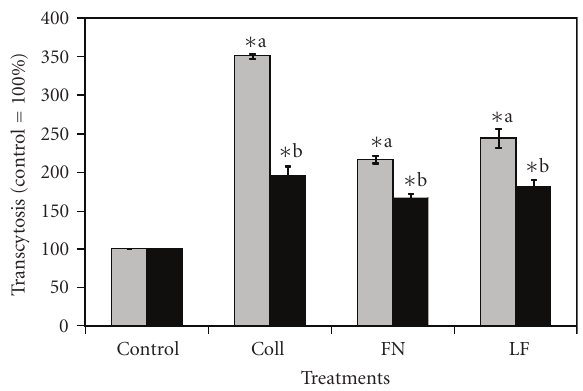
0200400600800100012001400 Figure 4: Transcytosis of Streptococcus uberis pretreated with host proteins across bovine mammary epithelial cells treated with the receptor mediated endocytosis inhibitor monodansylcadaverine detected at di ff erent incubation times. Fibronectin (FN), collagen (Coll), or bovine lactoferrin (LF) pre-treated S. uberis UT888 was cocultured with bovine mammary epithelial cells treated with the receptor-mediated endocytosis inhibitor monodansylcadaverine (MDC), and colony forming units per ml (cfu/mL) of S. uberis that transcytose bovine mammary epithelial cells were calculated at 60 ( ), 120 ( ), and 180 ( ) min of incubation. Data are presented as the percentage of transcytosis through monodansylcadaverine treated bovine mammary epithelial cells (100%, 60 minutes = 5.1 × 10 2 , 120 minutes = 6.3 × 10 2 ; 180 minutes = 1.0 × 10 3 ) at each incubation time and bars represent the standard error of the mean of three independent experiments run in triplicate. ( ∗ ) indicates statistically significant di ff erences ( P < . 05) with the corresponding control. Means with similar superscript letters within each sampling time are statistically di ff erent ( P < .